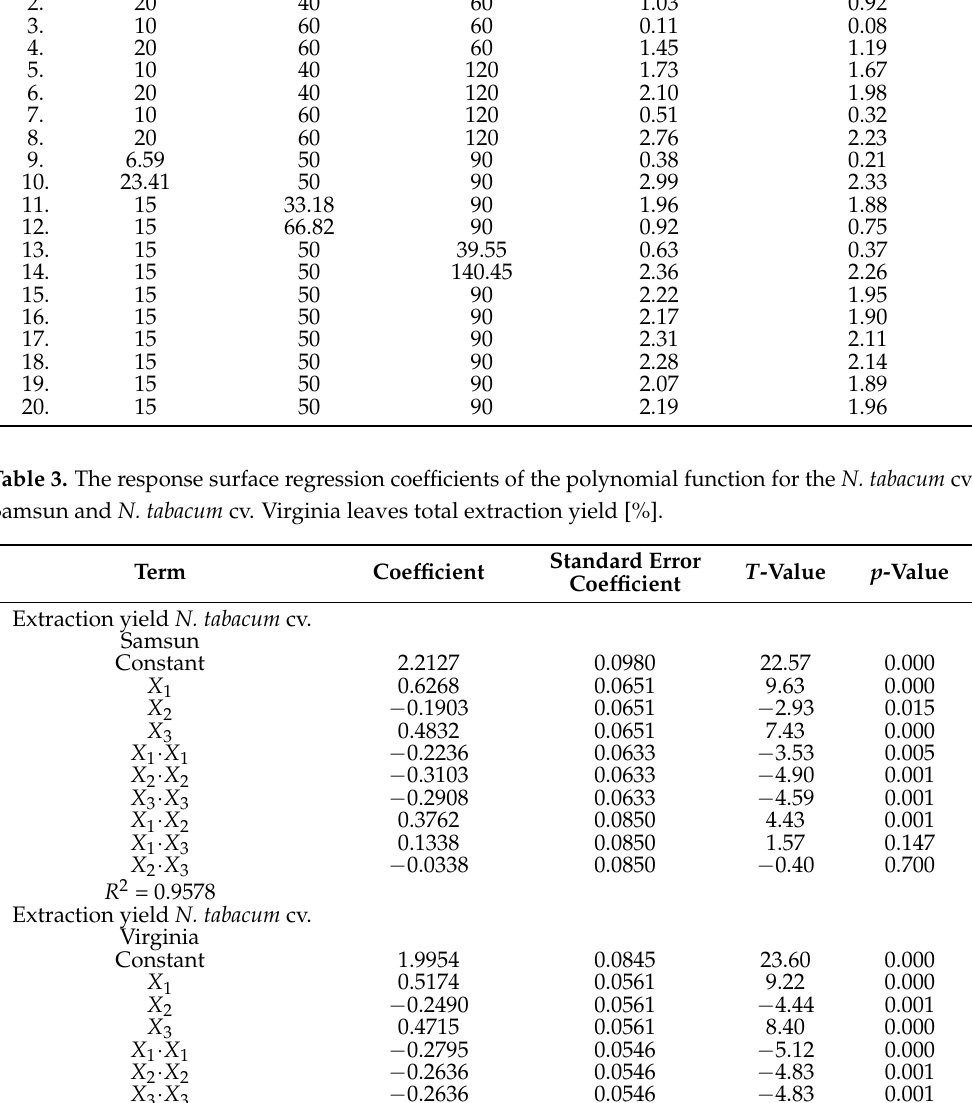
Extraction Yield Extraction Yield N. tabacum cv. N. tabacum cv.